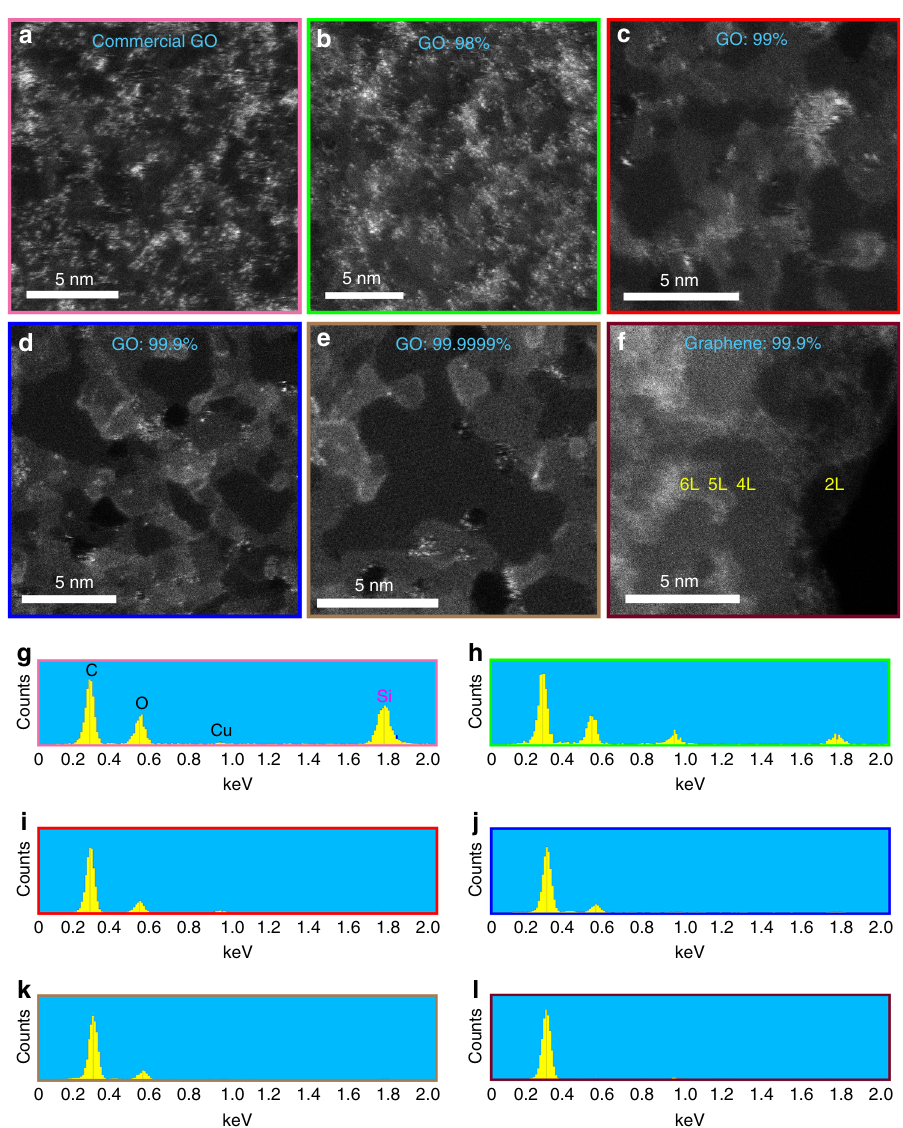
Fig. 6 HAADF images of graphene and graphene oxide samples with varying degrees of purity. a – e Varying contamination degree on GO synthesised from various graphite feedstocks (of differing purity) along with a commercially purchased material: a commercially sourced GO; b natural graphite fl ake (98% purity); c natural graphite fl ake (99% purity); d natural graphite fl ake (99.9% purity); e natural graphite powder (99.9999% purity). f Typical solvent- exfoliated graphene synthesised from graphite with 99.9% purity showing a very clean surface with almost no contamination. Numbers of layers are marked on the image. Scale bars in the images are 5 nm. g – l Comparison of the EDS spectra of the samples shown at a – f , respectively. The panels are colour-coded for